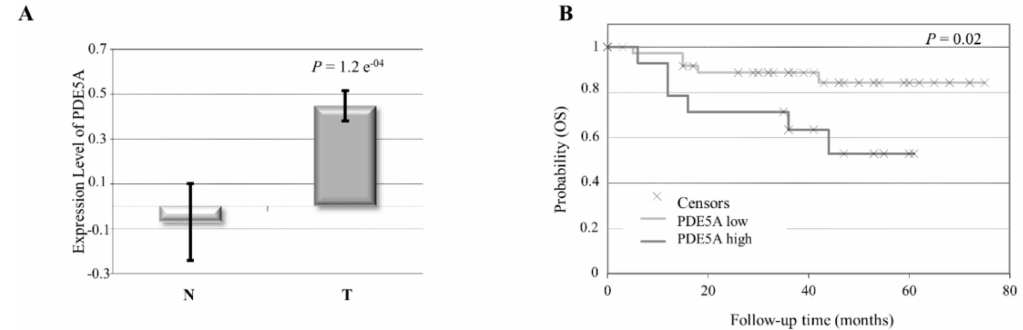
Figure 1. Phosphodiesterase (PDE) 5 expression levels in breast cancer stroma. ( A ) Gene expression levels of PDE5A in normal (N) and breast cancer (T) stroma samples. p = 1.2 e − 4 . ( B ) Kaplan–Meier survival analysis relating stromal PDE5 levels and overall survival (OS) in breast cancer patients. p =